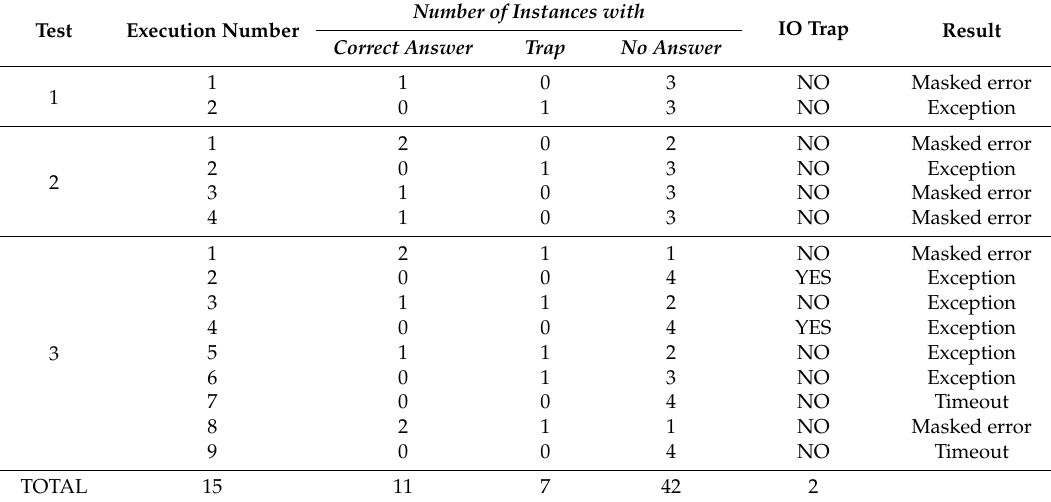
Table 6. Evaluation details of TSP NMR-MPar for 17